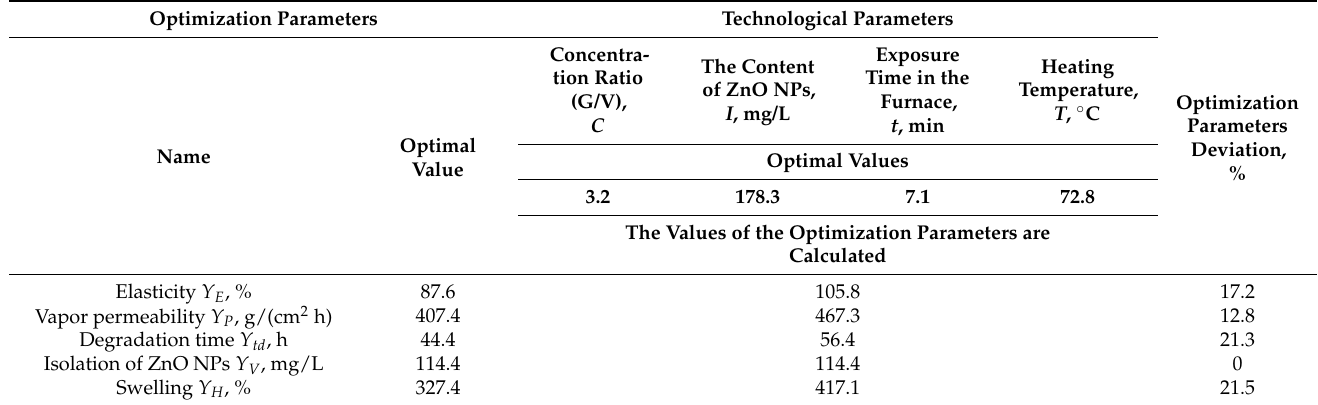
Table 3. The values of optimization parameters are calculated: Y E , Y P , Y td , Y H according to the optimal values of technological parameters of film formation at which the maximum isolation of ZnO NPs Y V